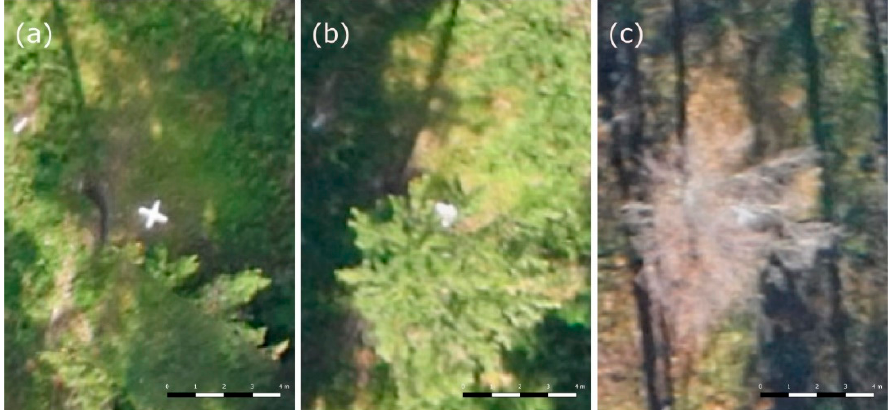
Figure 11. Possible influence of flight patterns (FP) and vegetation conditions on identification of points bordering with the vegetation. ( a ) FP 1, in this case parallel with the nearest edge of the adjacent tree, ( b ) FP 2, perpendicular to this edge, ( c ) the same point under leaf-off condition.